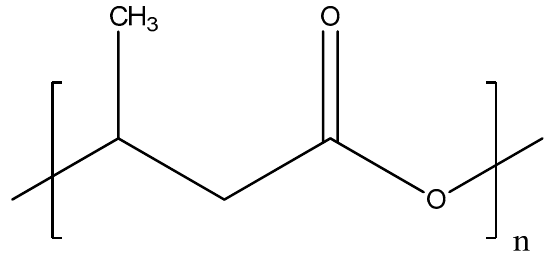
Figure 3. Chemical structure of polyhydroxybutyrate.